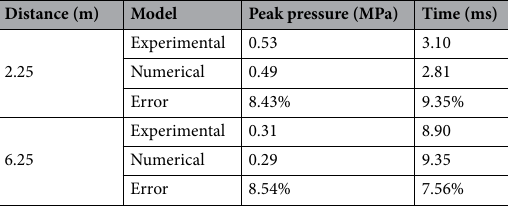
Table 3. Comparison of experimental and numerical outputs for the verification